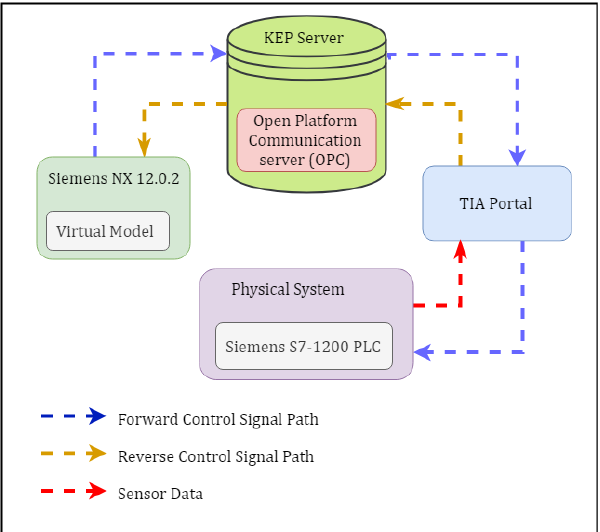
Figure 3. Block diagram of the digital twin